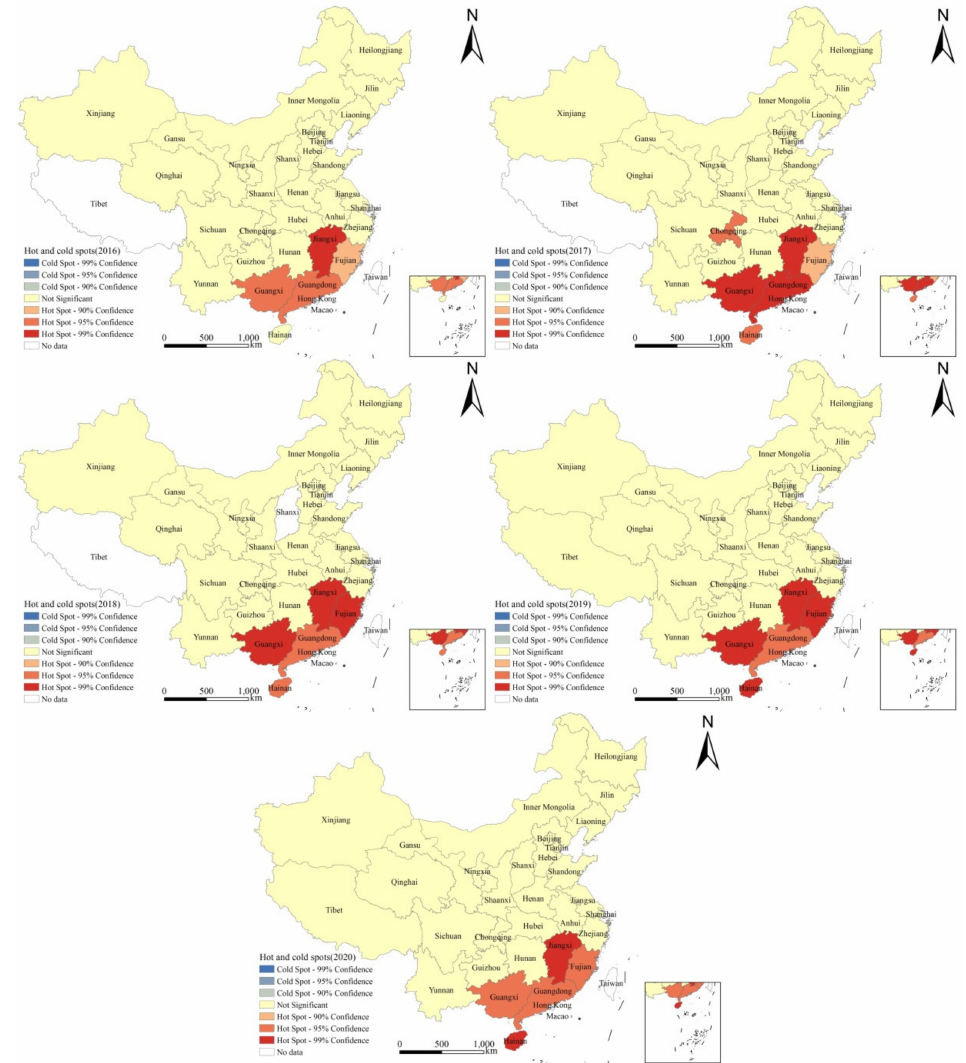
Figure 3. The provincial results of Getis-Ord Gi * from 2016 to 2020. The results of the hotspot analysis at the county level (Figure 4) demonstrated that “hot spots” included partial districts and counties in Hainan, Guangxi, Guangdong, Fujian, Jiangxi, Hunan, Chongqing, Sichuan, Guizhou, Anhui, Hubei and Henan, while the “cold spots” included some districts and counties in Liaoning, Jilin, Heilongjiang, Inner Mongolia, Hebei, Ningxia and